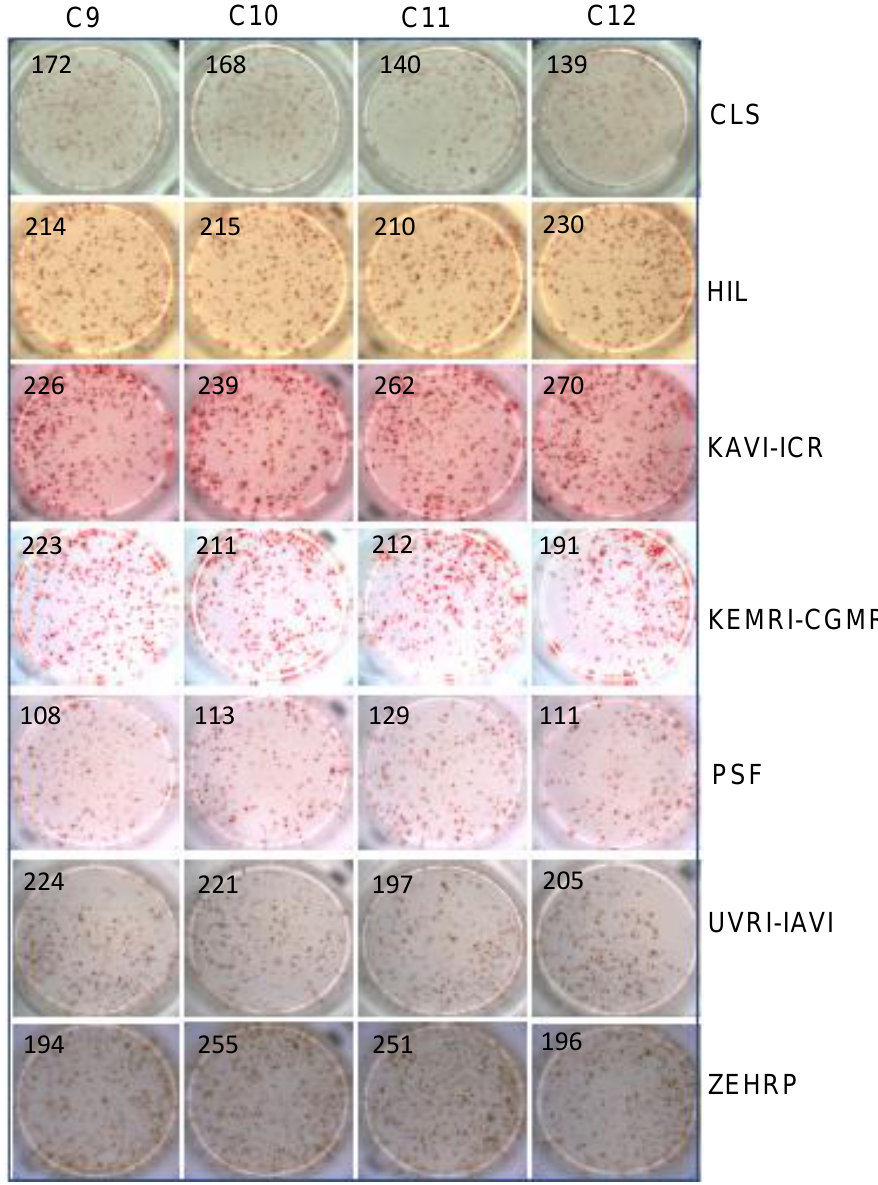
FIGURE 2-S1: PBMC ELISpot responses against CMV peptides . Representative well images (plate wells C9 to C12) of the CMV responses for sample 3522 performed in quadruplicates across the laboratories. The SFC counted per well are given in each well